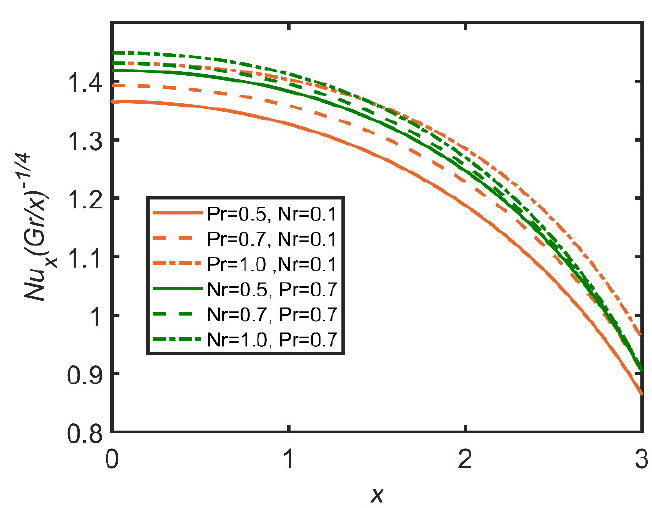
Figure 10. Comparison for Nusselt number profile against x.